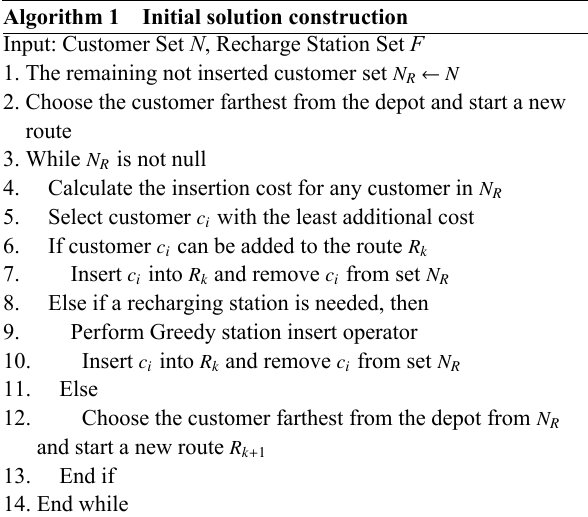
Algorithm 1 Initial solution